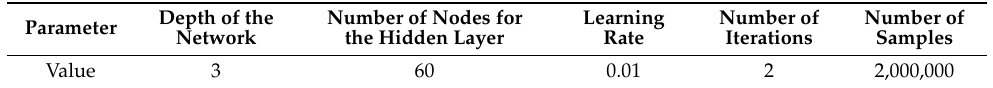
Table 2. DBN parameters.